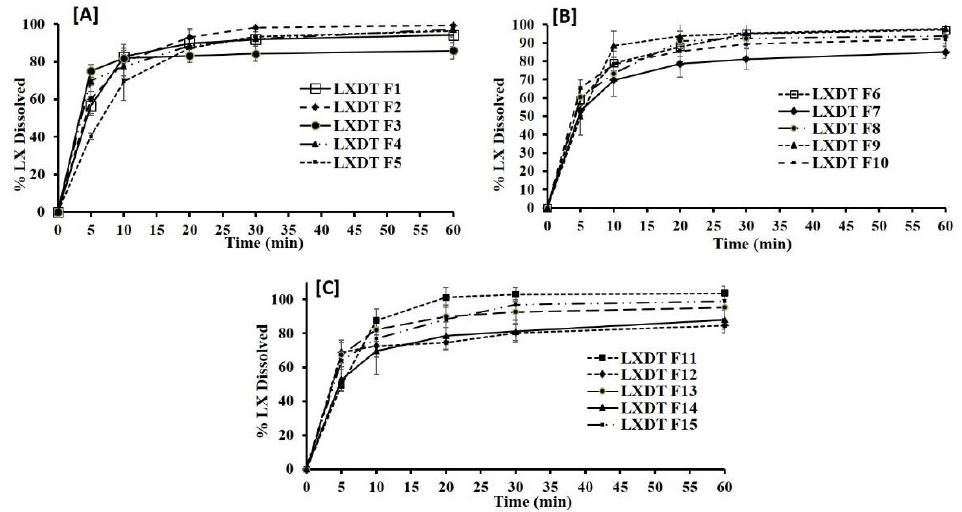
Figure 4. In vitro dissolution profile of LXDT formulations ( A ) LXTD F1 – F5, ( B ) LXTD F6 – F10, and (C) LXTD F11 – F15 .